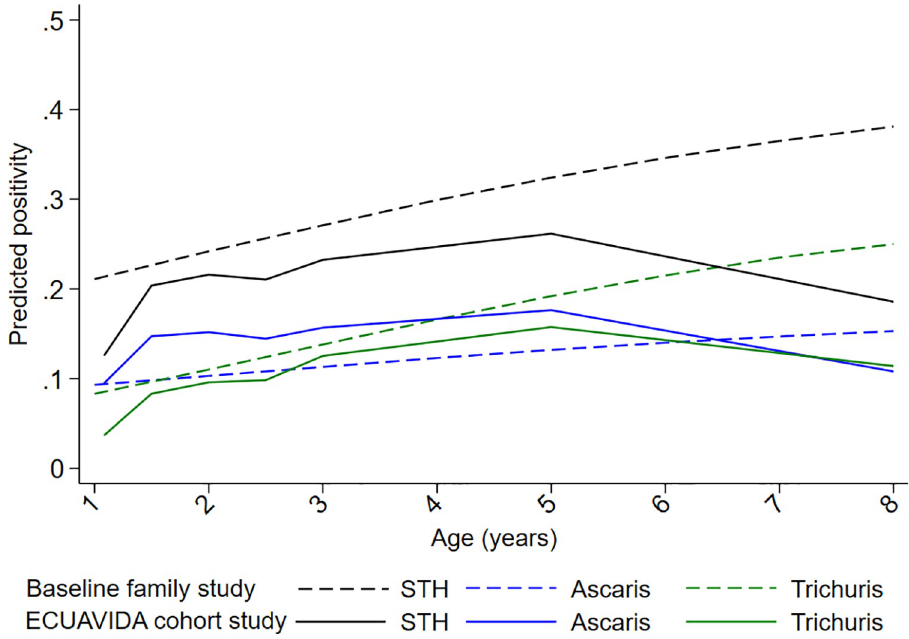
Fig 6. Age-dependent prevalence of infections with soil-transmitted helminths (STH). This includes any STH, A . lumbricoides (Ascaris), and T . trichiura (Trichuris) between 1 and 8 years of age comparing ECUAVIDA cohort (solid lines) with risk at the time of cohort recruitment among other children in the household (Baseline family study–dotted lines).